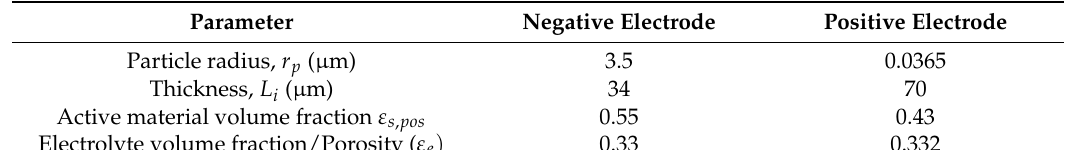
Table 2. Design parameters of the reference case [28], 10 Ah LFP pouch cell.